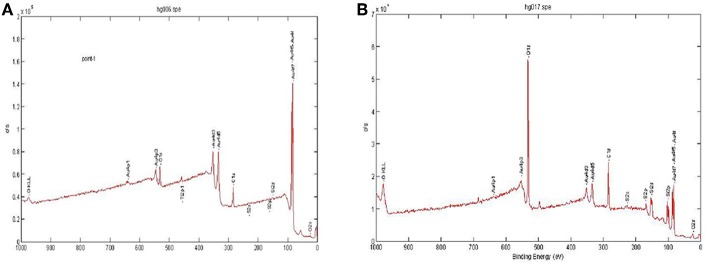
X-ray photoelectron spectroscopy (XPS) analysis of the microcantilever with or without HS-ssDNA oligomer SAM configuration. (A) Details of the XPS analysis of the microcantilever with SAM configuration. (B) Details of the XPS analysis of the reference microcantilever without SAM configuration.